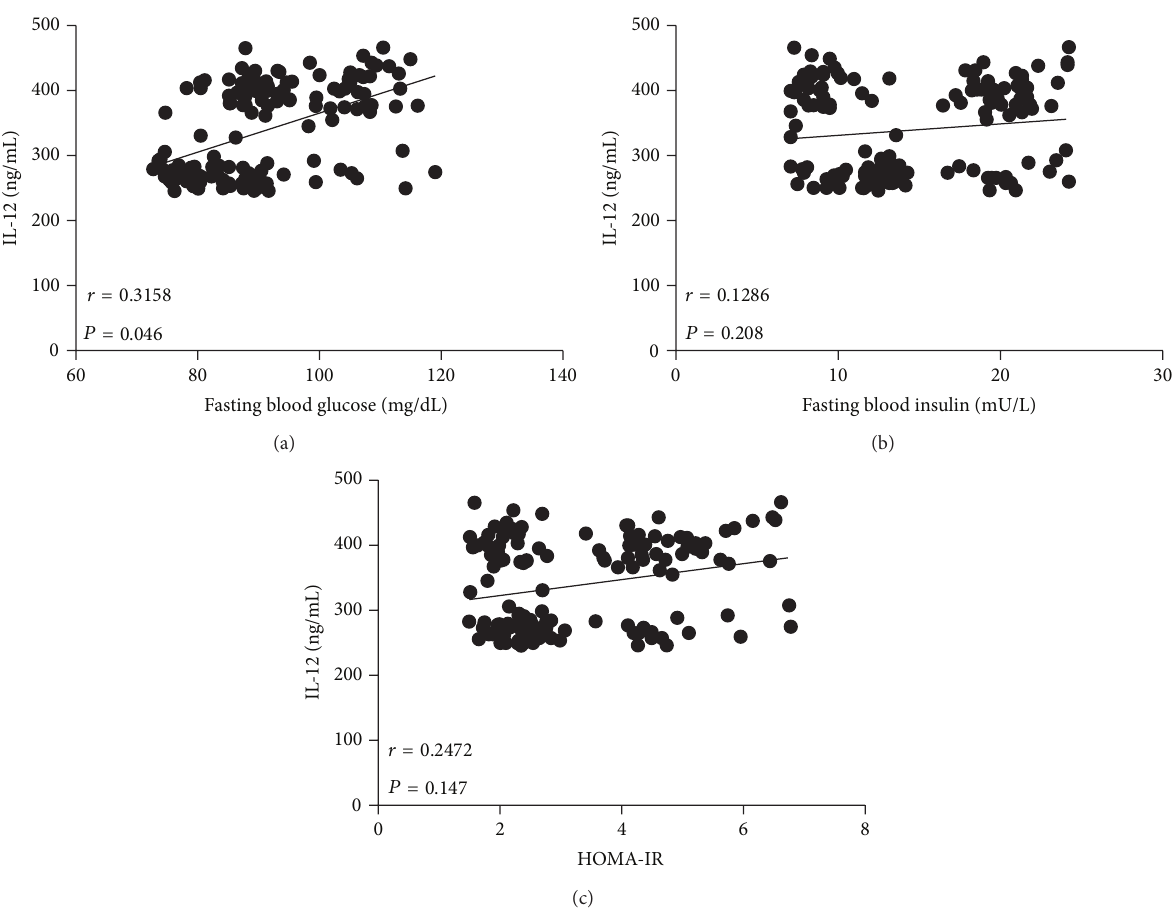
Figure 3: Relationship of the serum levels of IL-12 with fasting blood glucose, fasting blood insulin, and HOMA-IR. Serum IL-12 showed a positive significant association with high glucose levels (a), but not with insulin (b) or insulin resistance (c). The level of insulin resistance was estimated using the HOMA-IR index, which results from the next equation: fasting insulin concentration (mU/L) × fasting glucose concentration (mmol/L) divided by 22.5. Coefficients ( r ) and P values were calculated by the Spearman’s correlation model. The correlation level was considered significant when 𝑃 < 0.05 .